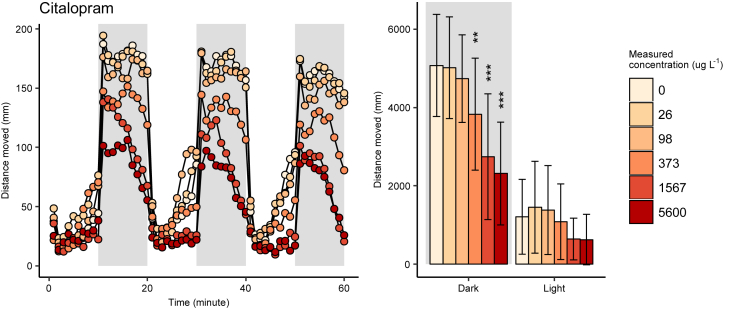
Total swimming distance in six-day post-fertilization zebrafish embryo-larvae exposed to citalopram since fertilization (**: p<0.01, ***: p<0.001 according to Dunnett's post hoc test). Adapted from Bachour et al. (2020) [2].